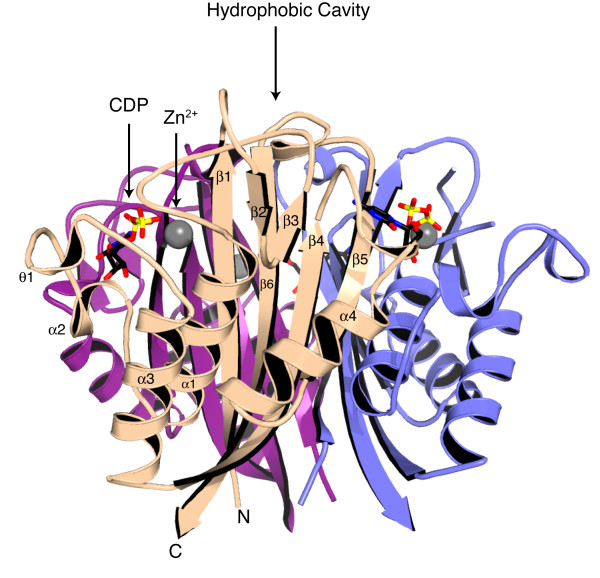
Ribbon diagram of the trimer. Orthogonal view compared to Figure 7.